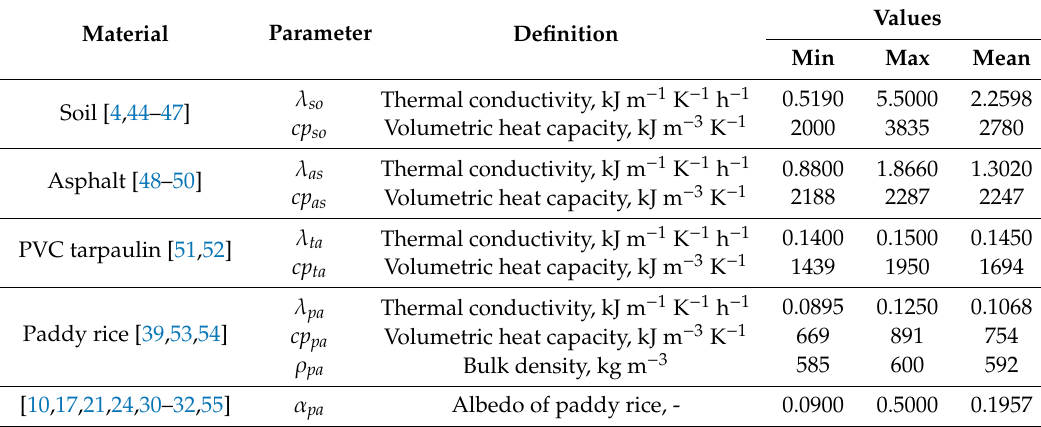
Table 1. Model input parameters from the literature.